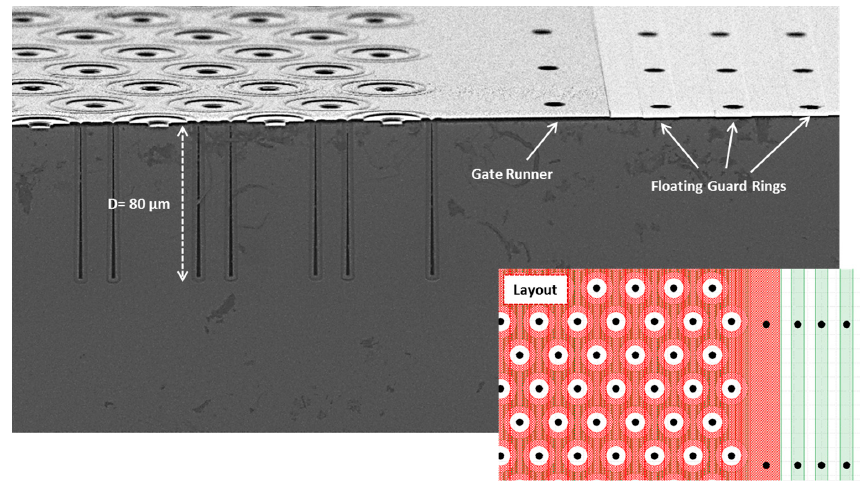
Figure 5. SEM image of a cross section through the center of a row of cells, obtained on a V-JFET sample before the metal deposition. Several peripheral elements (gate runners and guard rings) can be observed together with the arrangement of parallel cells. A depict of the layout is also shown in the bottom right inset.